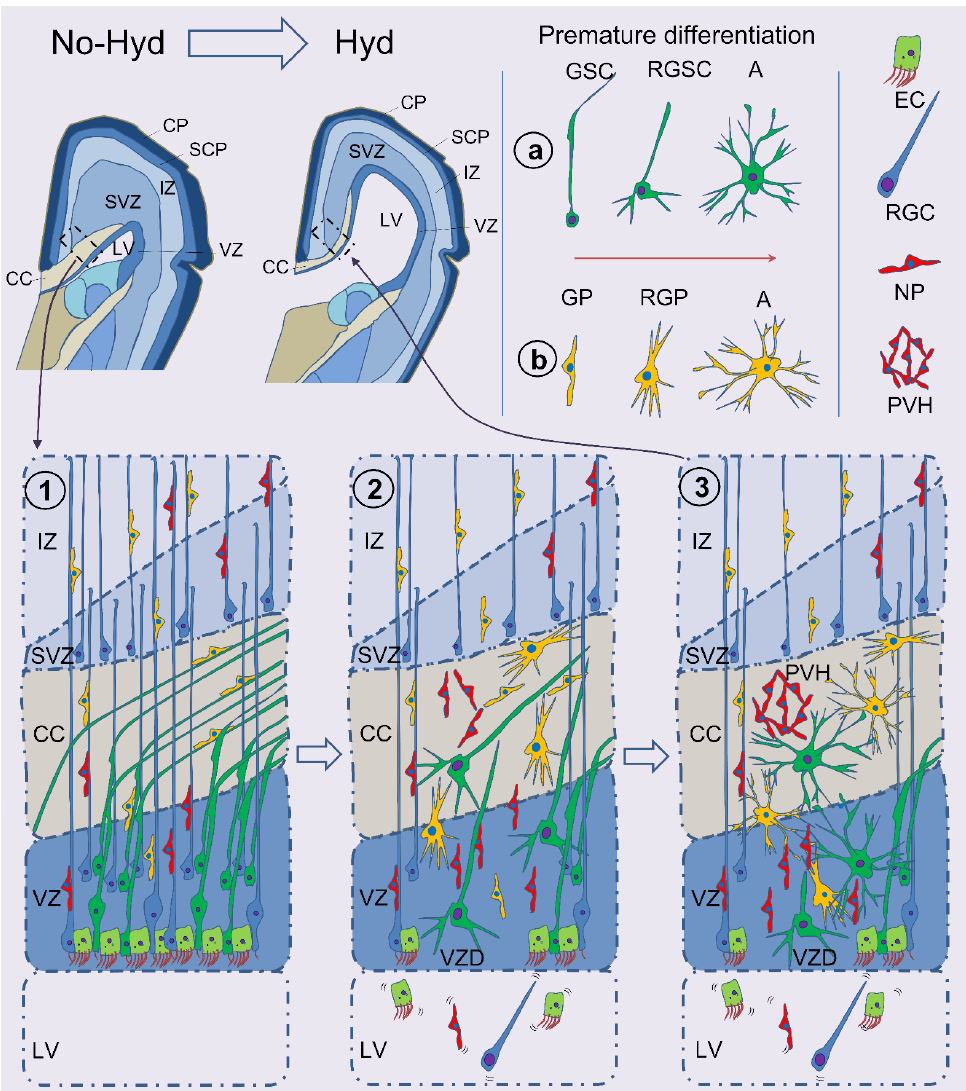
Figure 2. Schematic representation of astrocyte’s premature differentiation in hydrocephalus. In non-hydrocephalic conditions, after mid-gestation at the periventricular white matter areas, the ventricular zone is mainly composed of ECs, RGCs, GSCs, GPs, and NPs (1). When hydrocephalus pathology develops, a ventricular lining disruption occurs, associated with reactive astrogliosis (2). This representation proposes that white matter-associated GSCs and GPs become activated under hydrocephalic conditions suffering a premature differentiation into astrocytes (a,b). This early GSC differentiation into astrocytes impairs its normal function as a scaffold to guide cells into the white matter, implying a lack of cell migration resulting in the characteristic hypoplasia or dysgenesis of the white matter tracks. In turn, the incapability of NPs to migrate triggers periventricular heterotopias. Finally, a premature differentiation of GPs into astrocytes as a reaction to an inflammatory response may alter the final fate of the cells and affect their migration (3). LV, lateral ventricle; MZ, marginal zone; CP, cortical plate; SCP, subcortical plate; IZ, intermediate zone; SVZ, subventricular zone; VZ, ventricular zone; VZD, ventricular zone disruption; CC, corpus callosum; IC, internal capsule; GSC, glial stem cell; RGSC, reactive glial stem cell; GP, glial progenitor; RGP, reactive glial progenitor; A, astrocyte; RGC, radial glial cell; NP, neural progenitor; PVH, periventricular